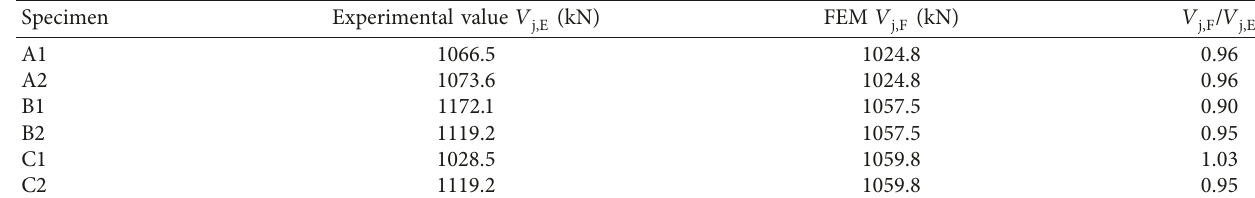
Table 4: Comparison of the test value and finite element of shear bearing capacity.